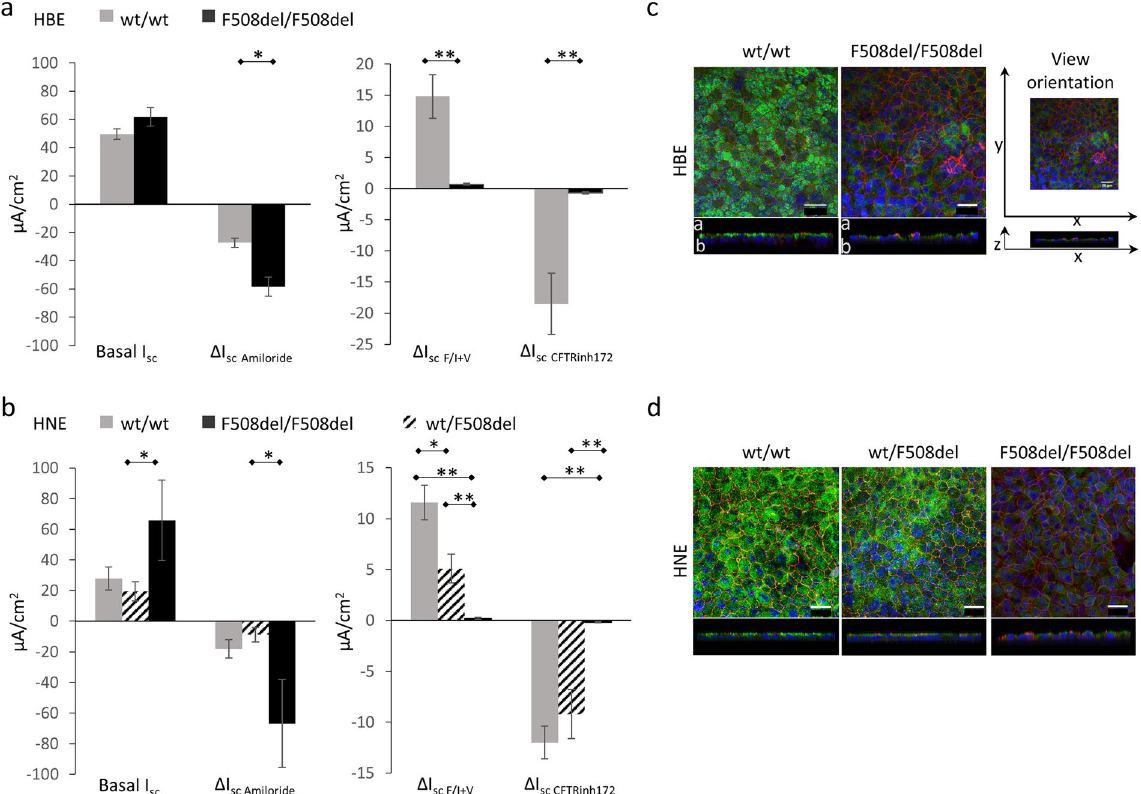
Figure 1. Characteristics of the trans-epithelial ion transport and CFTR expression in HBE and HNE cell cultures. Mean and SEM values for Basal I sc , ∆ I scAmiloride , ∆ I scF/I + V and ∆ I scCFTRinh172 ( µ A/cm 2 ) were calculated from median values per patient. Comparison by non-parametric Mann Whitney test. At least 2 filters were analyzed per patient. The p -values for statistically significant differences are indicated as * < 0.05 and ** < 0.01. ( a ) Comparison of wt/wt (grey) and F508del/F508del (black) HBE cell cultures issued from non-expanded cells. ( b ) Comparison of wt/wt (grey), wt/F508del (dashed), and F508del/F508del (black) HNE cell cultures issued from non-expanded cells. Representative confocal microscopy images of immuno-fluorescent staining of CFTR (green) and Zona-Occludens-1 (red) in HBE ( c ) and HNE ( d ) cell cultures according to genotypes. Top and side views of three-dimensional (3D) reconstitutions (a: apical face, b: basal face of epithelium). Scale bars = 20 µ m.